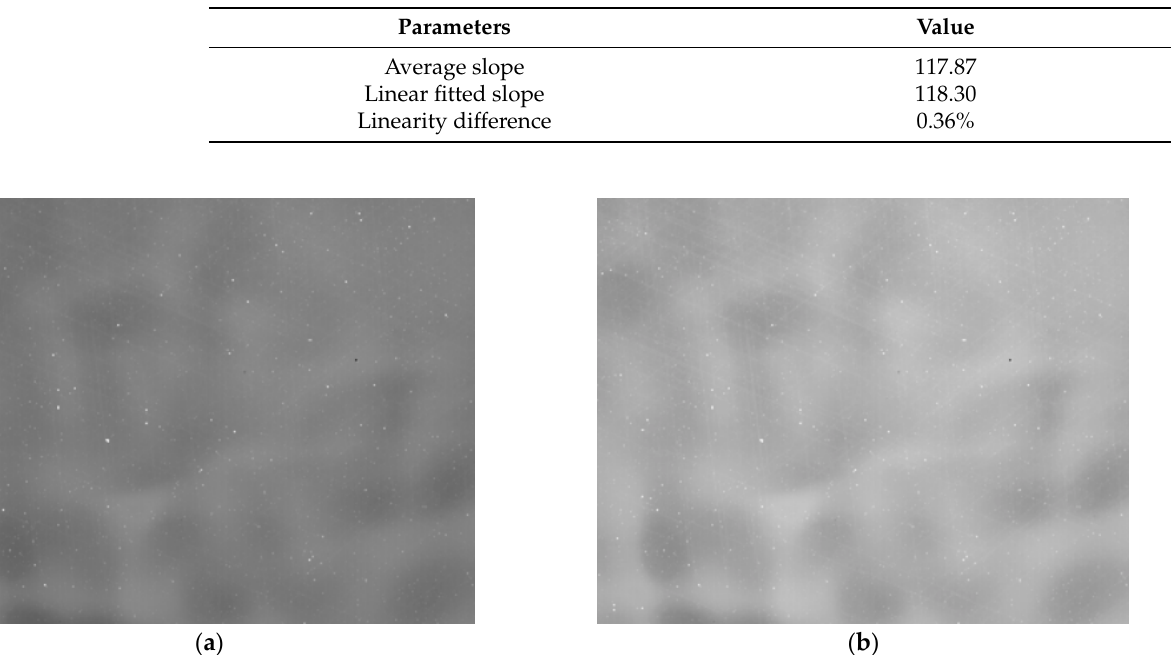
Figure 8. Blackbody reference raw images for low and high temperatures. ( a ) − 10 °C reference image (average gray value 7591DN); ( b ) 10 °C reference image (average gray value 10117DN). Table 2. Response linearity of IRFPA for the range − 20~10 ℃